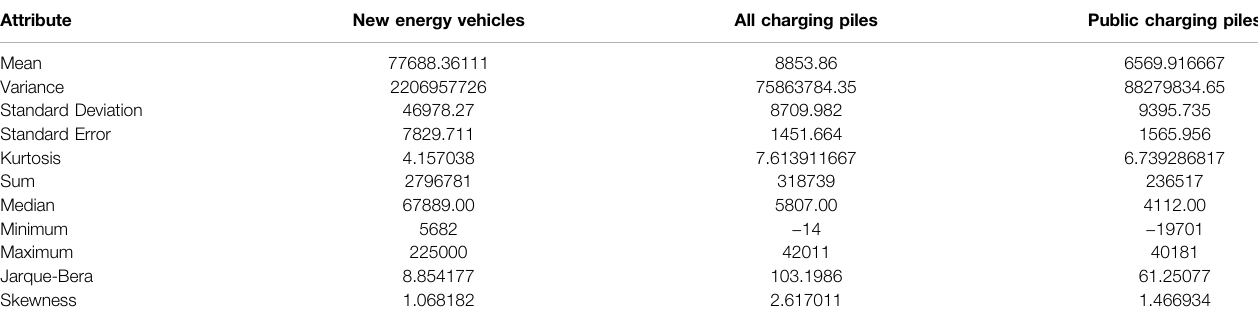
TABLE 2 | Statistical results of collected data of EVs, all charging piles, and public charging